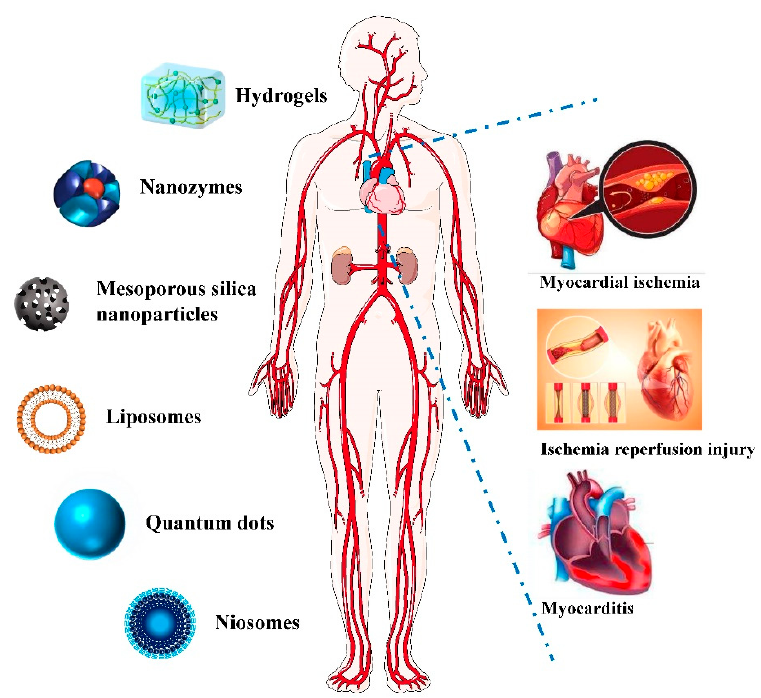
Figure 1. Application of Nano-theranostics for myocardial injury.